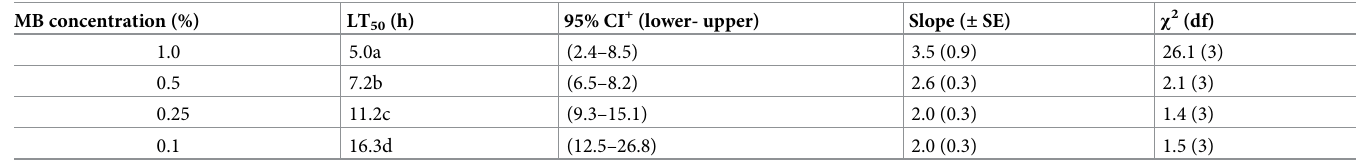
Table 6. LT 50 values from fumigation bioassay of methyl benzoate (MB) against Bemisia tabaci adults for different concentrations (n = 90). MB concentration